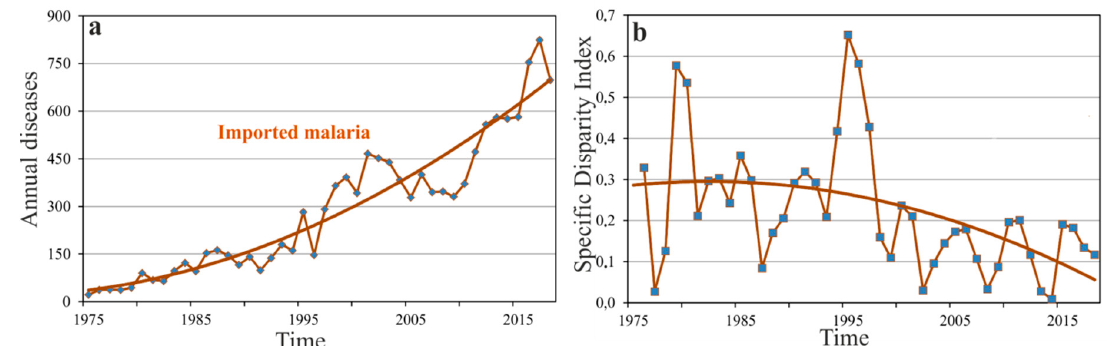
Figure 2. Evolution of: ( a ) absolute number of people infected with imported malaria; and ( b ) specific disparity index of morbidity by imported malaria in Spain from 1975 to 2018.